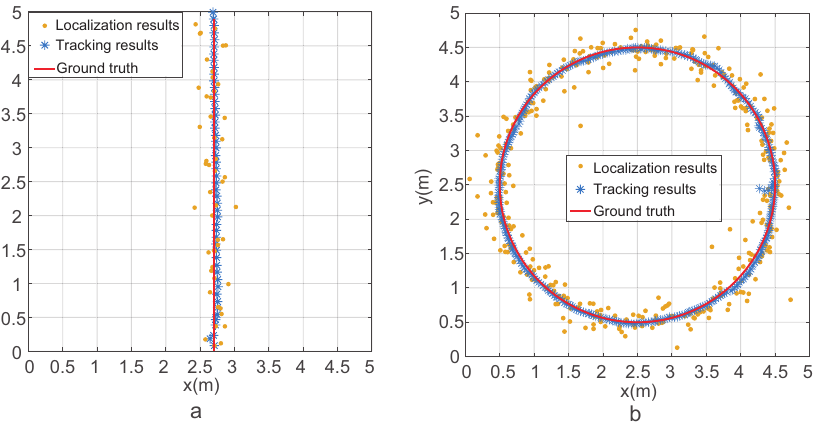
Figure 5. The localization and tracking results when RFID reader could read four neighboring tag. ( a ) The localization and tracking results of the line trajectory. ( b ) The localization and tracking results of the circular